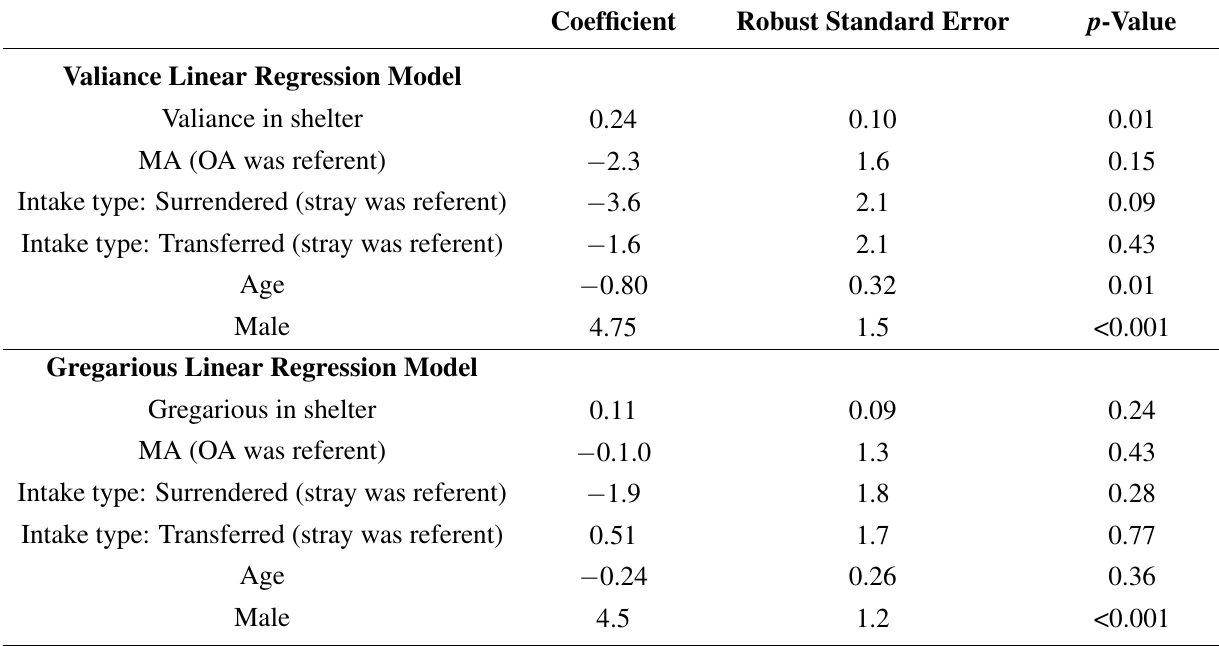
Table 5. Multiple linear regression looking at how well the Valiance or Gregarious scale in the shelter was associated with the Valiance or Gregarious Scale in the home,